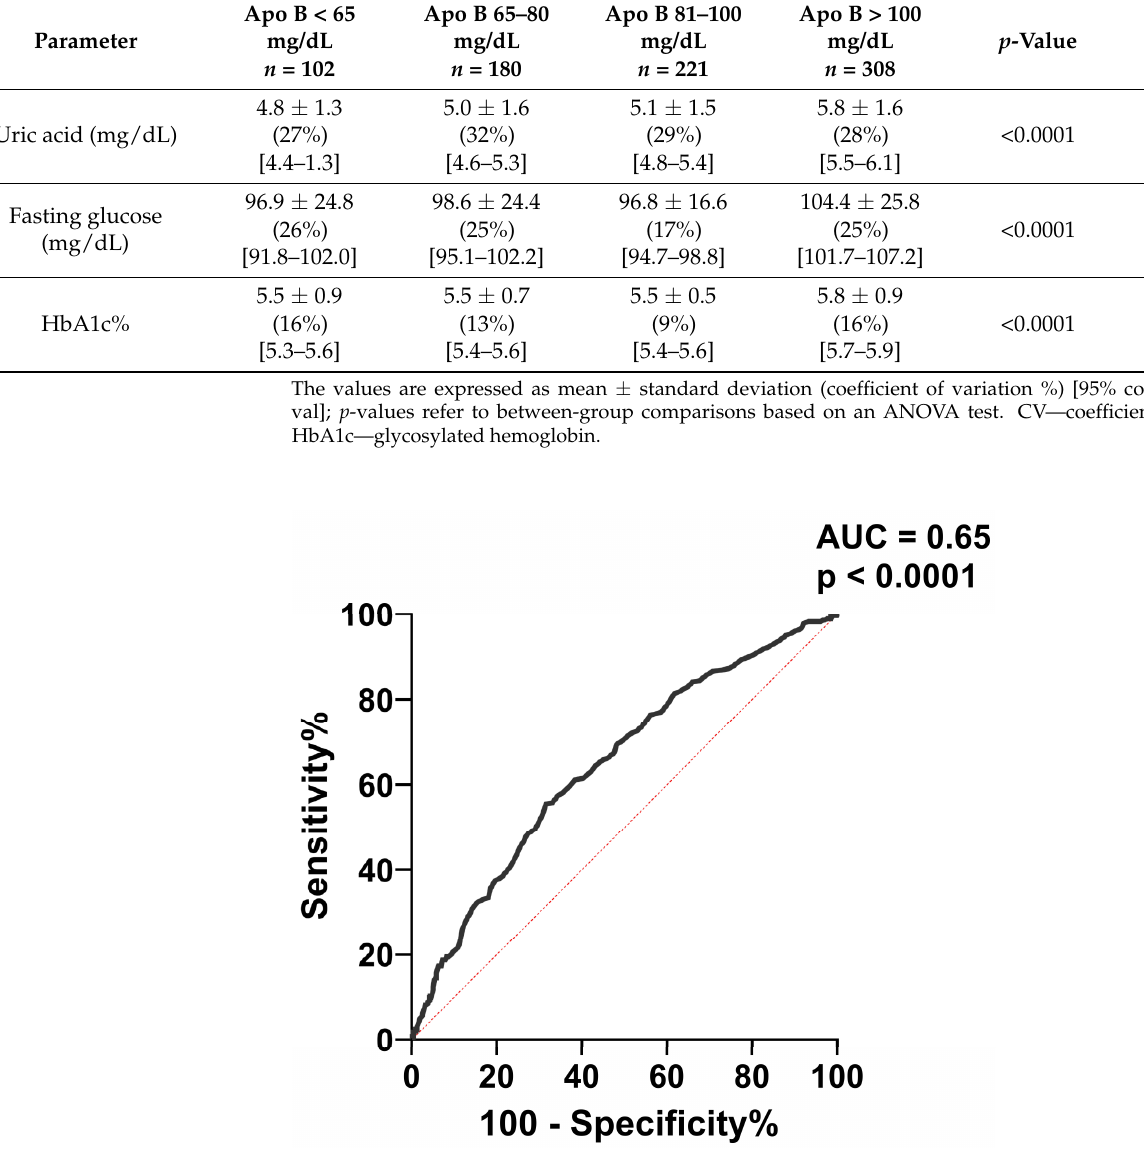
Figure 5. ROC analysis for the accuracy of Apo B level in predicting carotid plaques. AUC = area under the